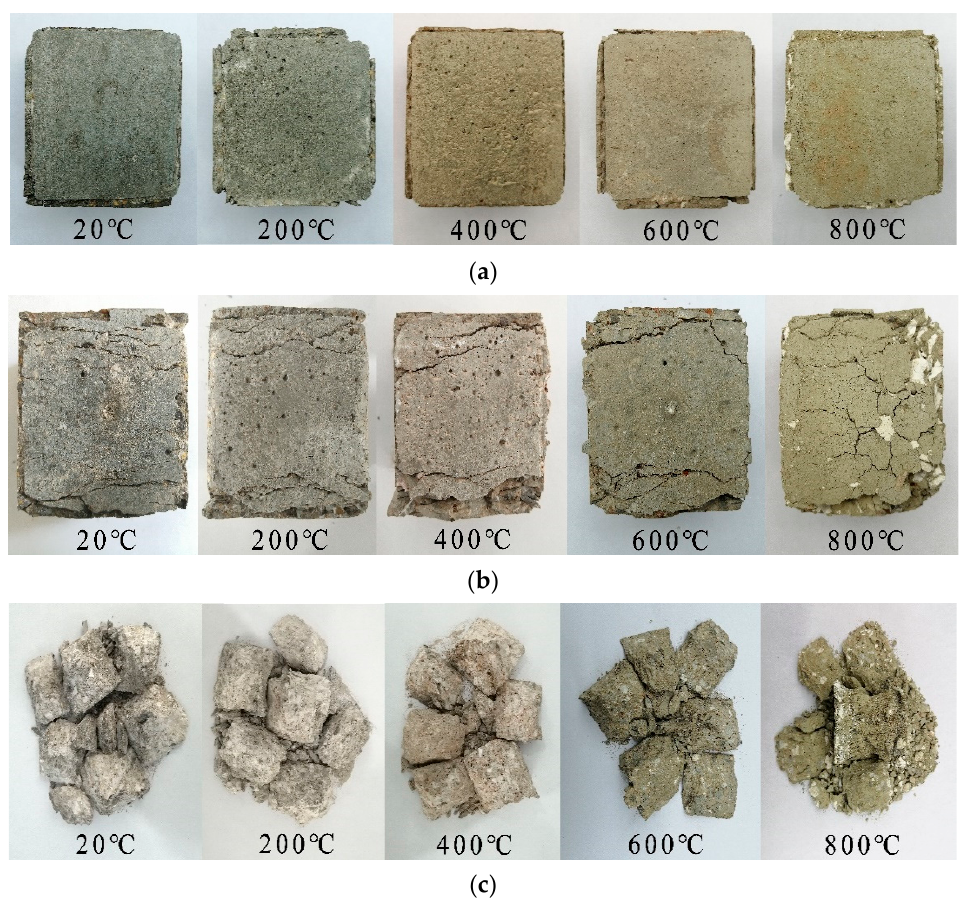
Figure 12. Typical failure mode of concrete in the high-temperature true triaxial static compression test. ( a ) Y-direction main pressure surface. ( b ) Side pressure surface in the X and Z directions. ( c ) Crushing form.